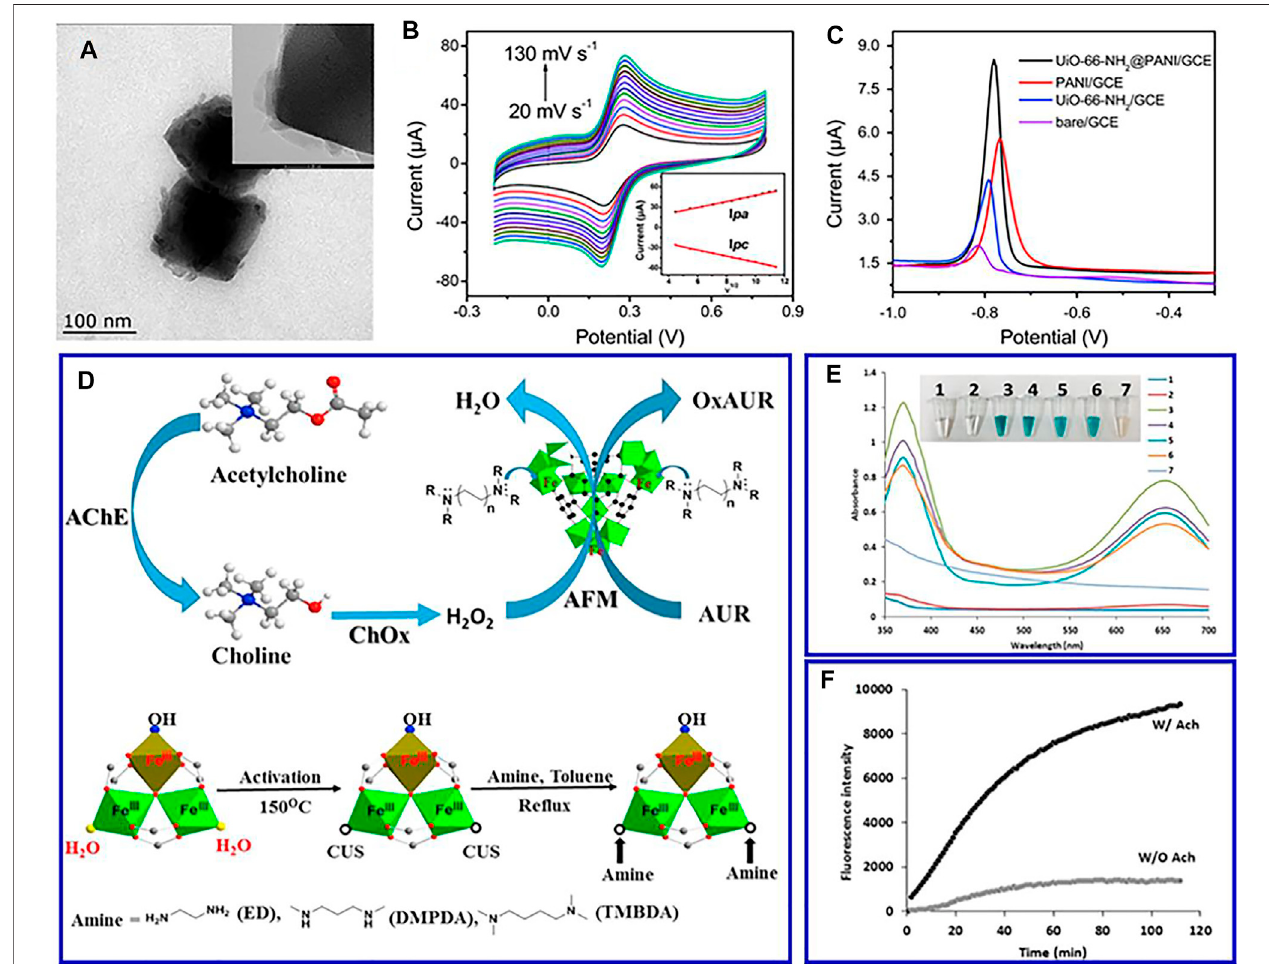
FIGURE 3 | TEM images (A) , CV in 0.1 mol L − 1 KCl solution with 1 mmol L − 1 Fe(CN) 63 − /4 − at different scan rates (B) , and differential pulse voltammograms